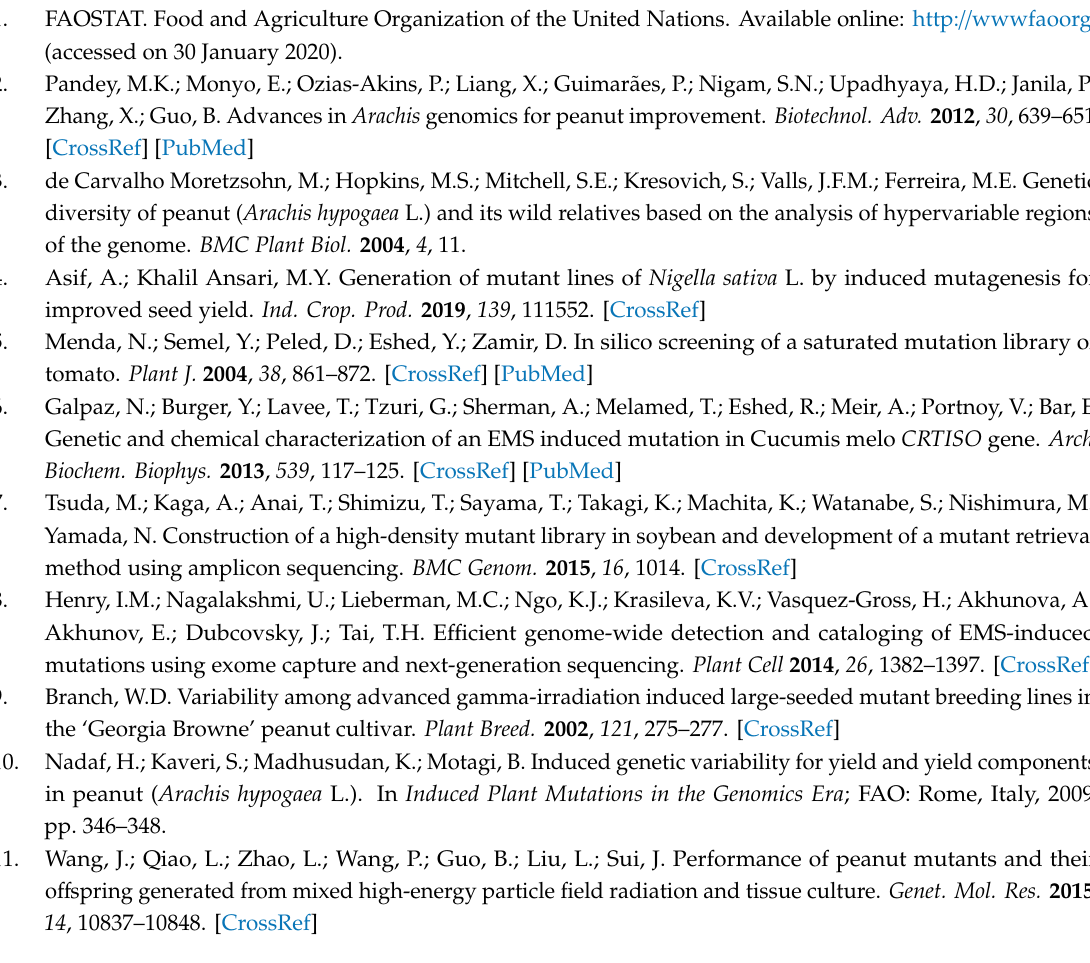
Table S1: LD50 calculation based on the lethal rate with di ff erent EMS